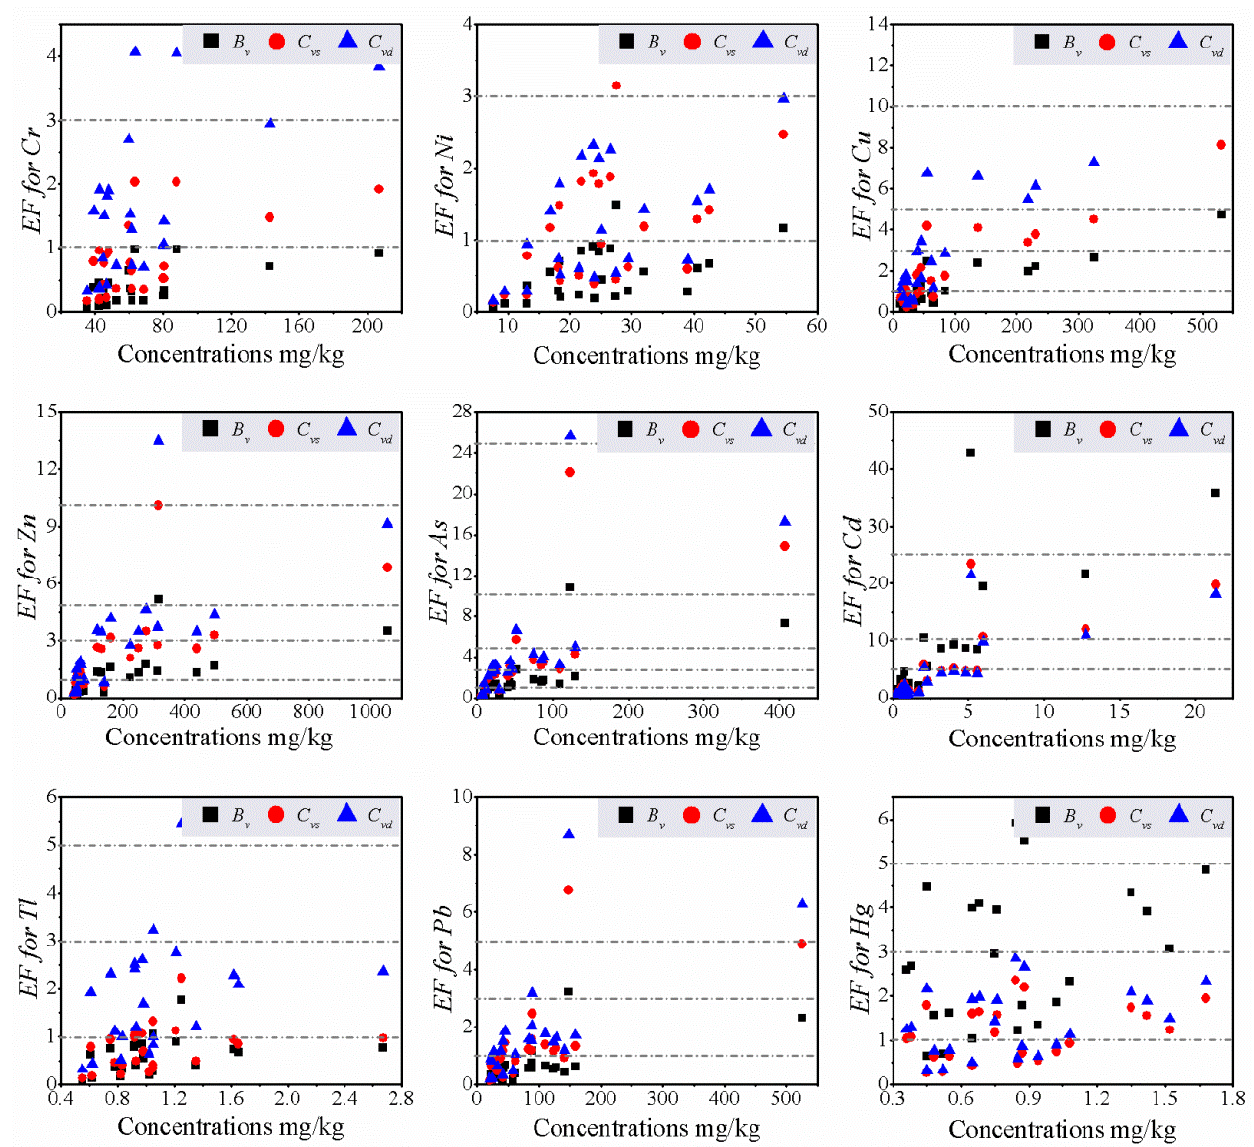
Figure 3. The EF values of Cr, Ni, Cu, Zn, As, Cd, Tl, Pb, and Hg in sediments were calculated based on different types of background values and total concentrations.